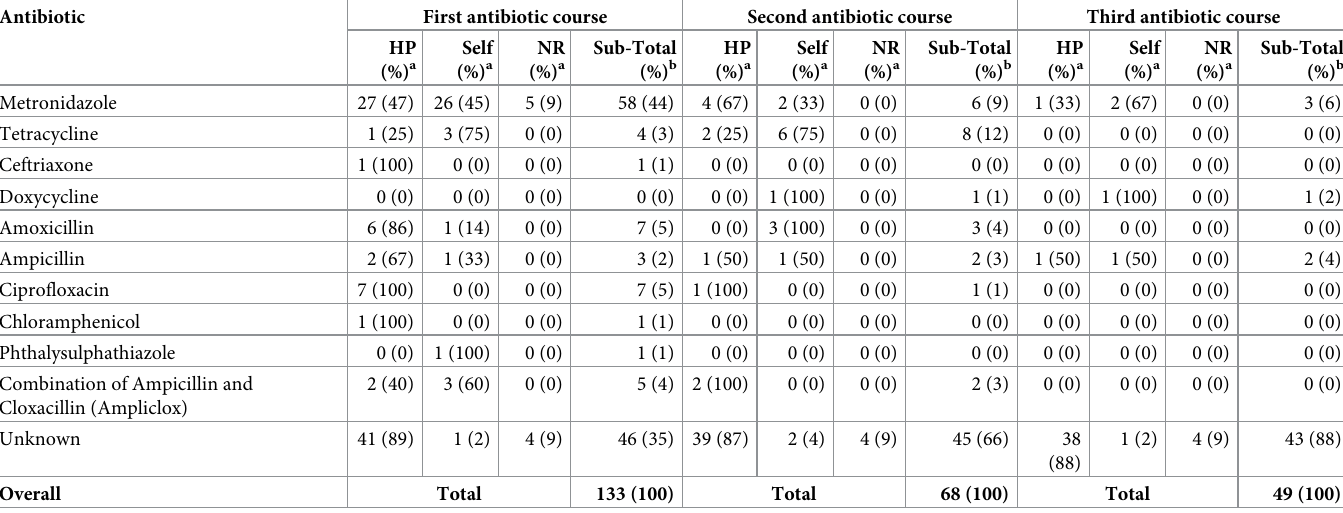
Table 2. Antibiotic courses reported by respondents.